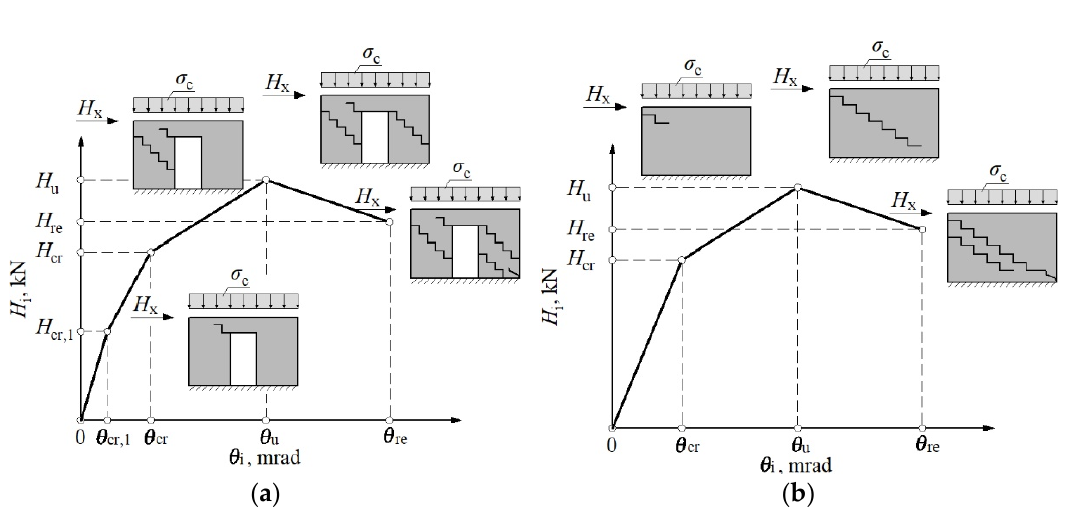
Figure 17. Behavior phases of stiffening walls; ( a ) wall with door opening ( b ) wall without door opening.